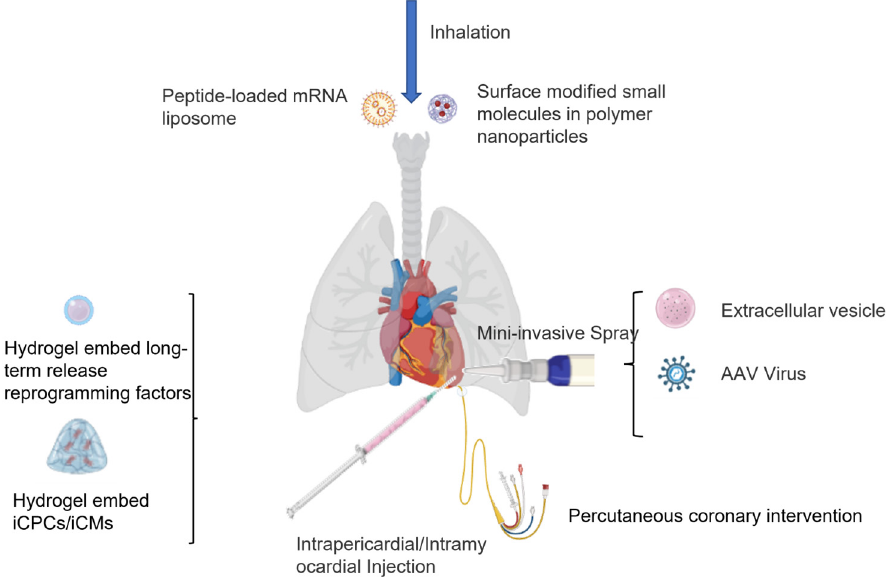
Figure 4. Administration methods for delivery of reprogramming factors and chemical molecules for reprogramming-based therapy.